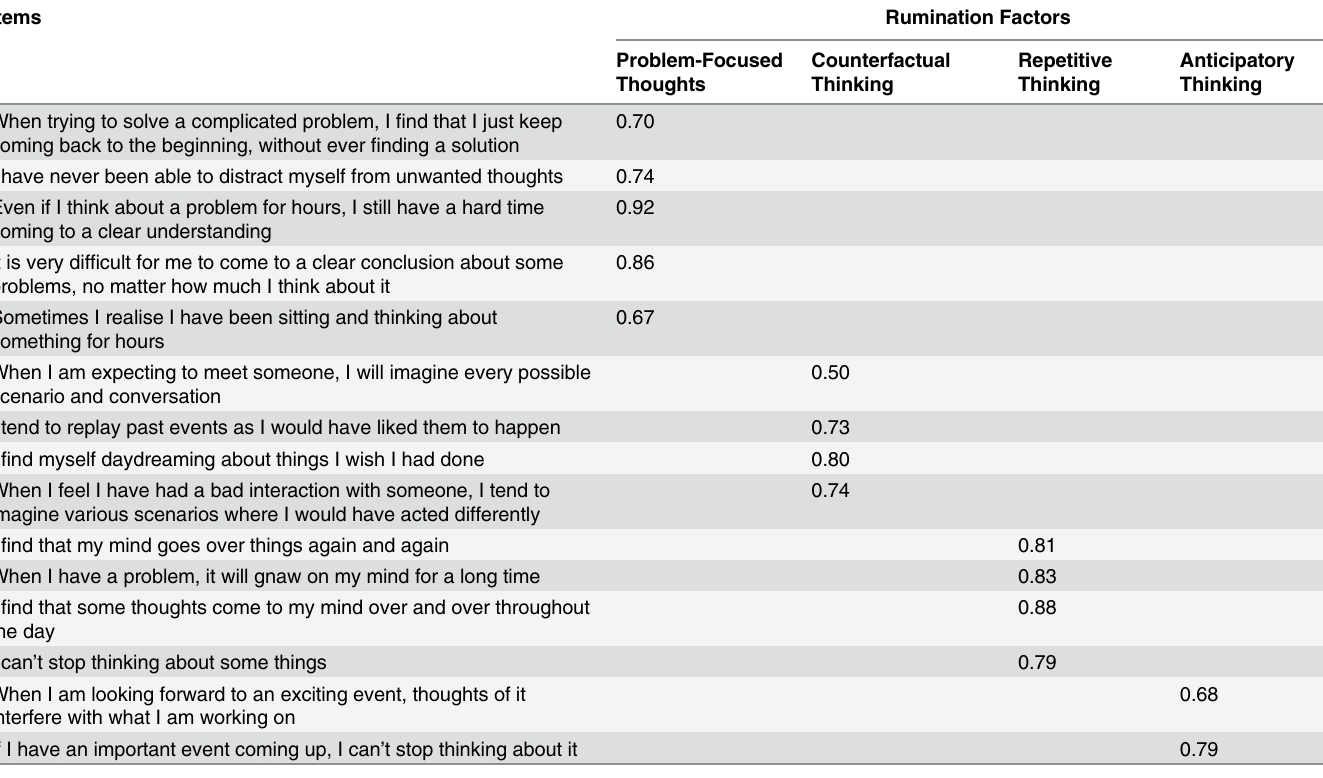
Table 4. Standardized Factor Loadings for the Four-Factor Rumination Model. Items